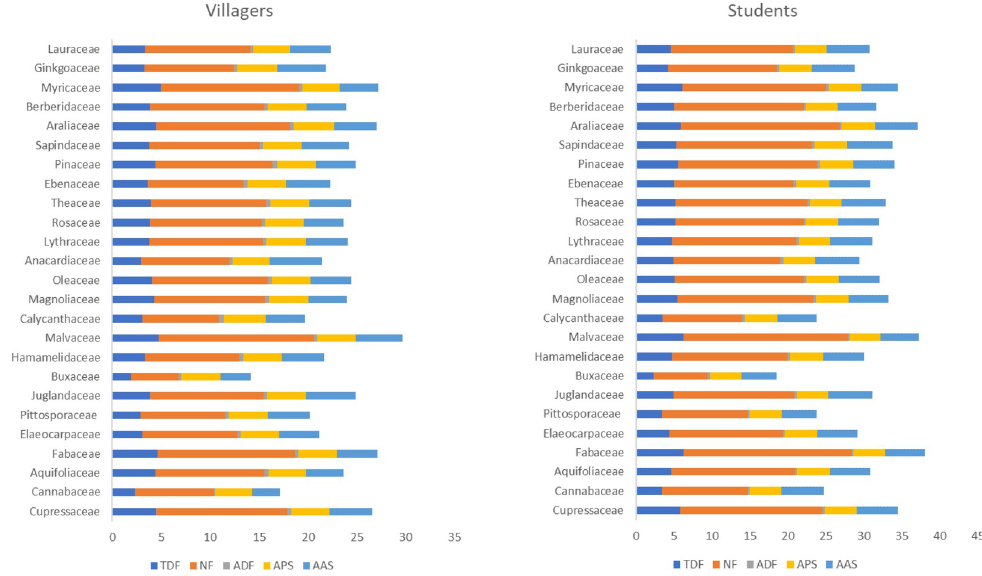
Fig 3. The average value of eye movement indicators of villagers and students at the level of families. TDF: Total duration of fixations; NF: Number of fixations; ADF: Average duration of fixations; APS: Average pupil size; AAS: Average amplitude of